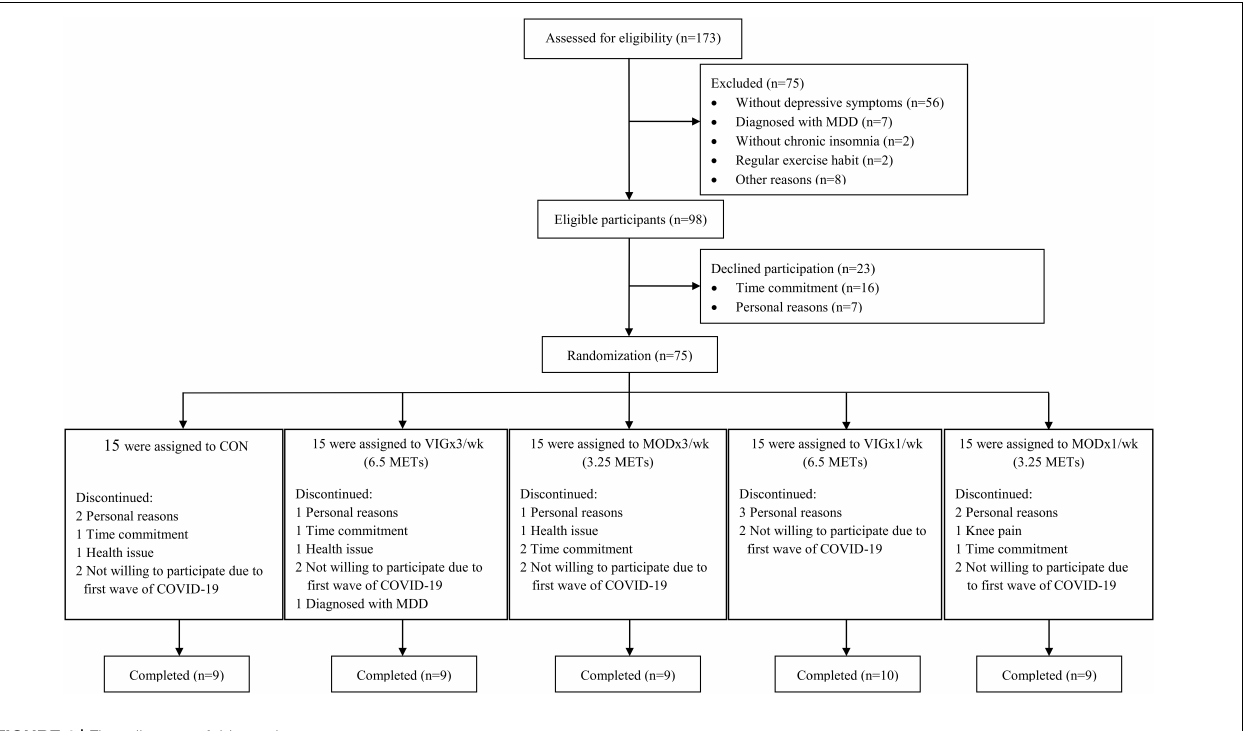
FIGURE 1 | Flow diagram of this